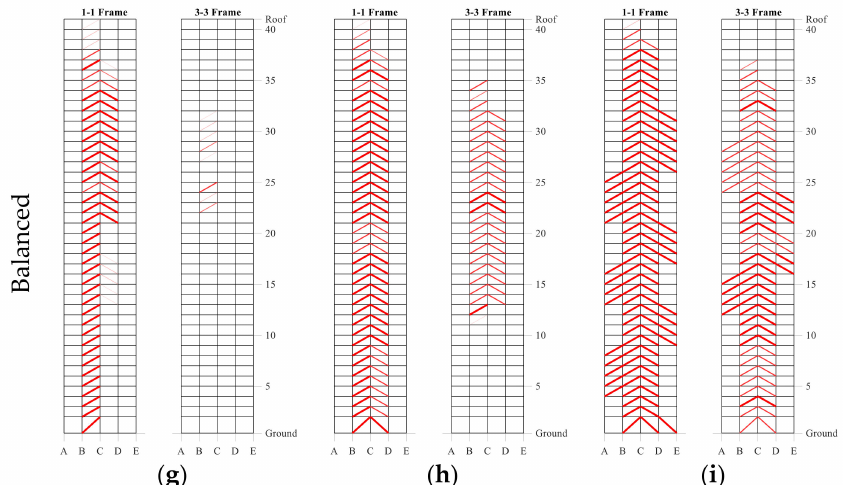
Figure 9. Damper design based on nine different retrofit schemes, ( a ) low damping and effective SFPDD, ( b ) medium damping and effective SFPDD, ( c ) high damping and effective SFPDD, ( d ) low damping and direct SFPDD, ( e ) medium damping and direct SFPDD, ( f ) high damping and direct SFPDD, ( g ) low damping and balanced SFPDD, ( h ) medium damping and balanced SFPDD, ( i ) high damping and balanced